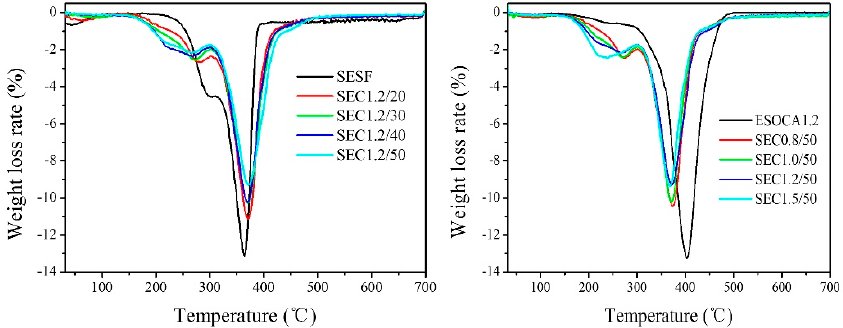
Figure 3. Differential thermogravimetric (DTG) curves of SEC biocomposites with different R values and ESOCA content.